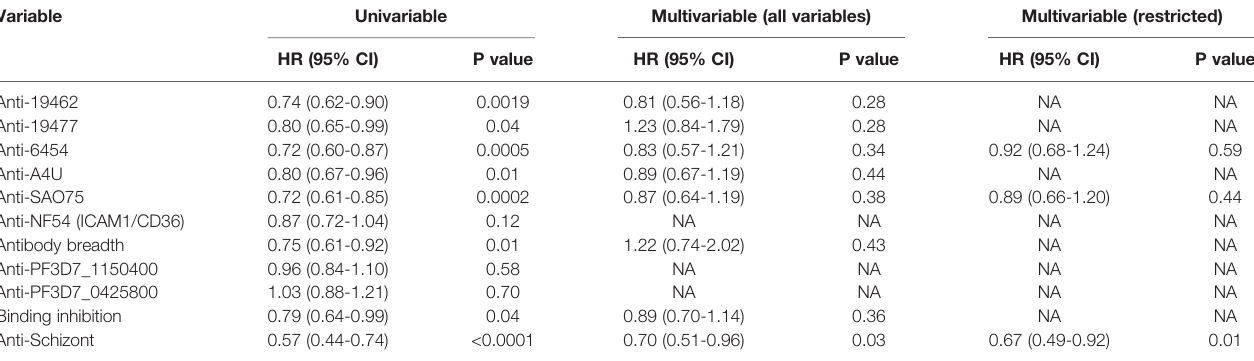
Multivariable (restricted): Stepwise regression including the factors indicated in the table. NA, Indicates factors not included in the model.